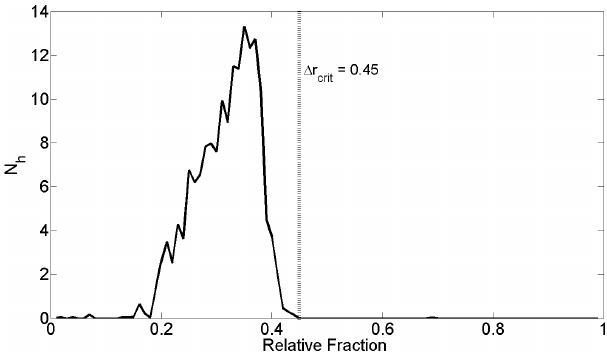
Figure 10. Mean number of holes found in 5% pointwise signif- icance patches as a function of (cid:49)r = (f 2 − f 1 )/f 2 for a sum of two sinusoids with amplitudes equal to unity and frequency compo- nents f 1 and f 2 such that f 2 > f 1 > 0. Additive white noise with a signal-to-noise ratio of 30 was added to the sum of sinusoids. Pointwise significance was tested against a red-noise background. Dashed line represents the critical value of (cid:49)r , the value beyond which holes will rarely occur between oscillations of equal ampli- tude (set to unity) with frequencies f 1 and f 2